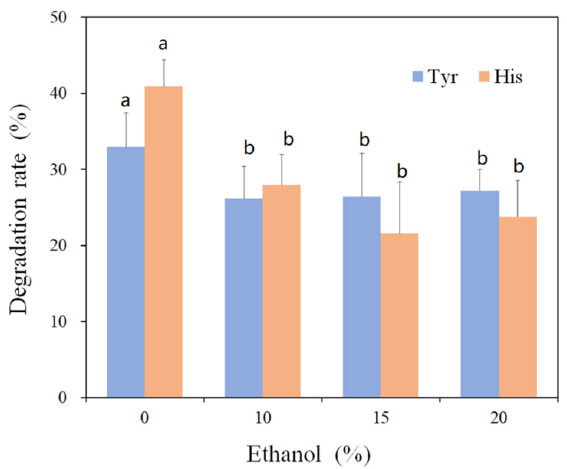
Figure 6. Effect of ethanol content on the activity of rMCO towards histamine and tyramine. Different letters indicate significantly different ( p < 0.05) mean values.